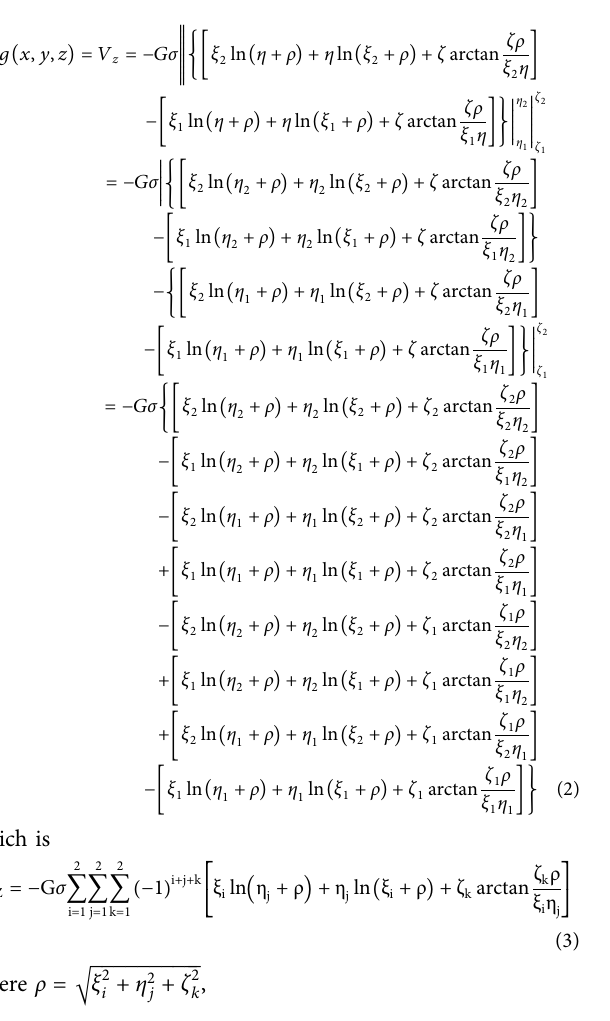
FIGURE 2 | Cross-sectional model of the gravity anomaly of an upright, high-density orebody.